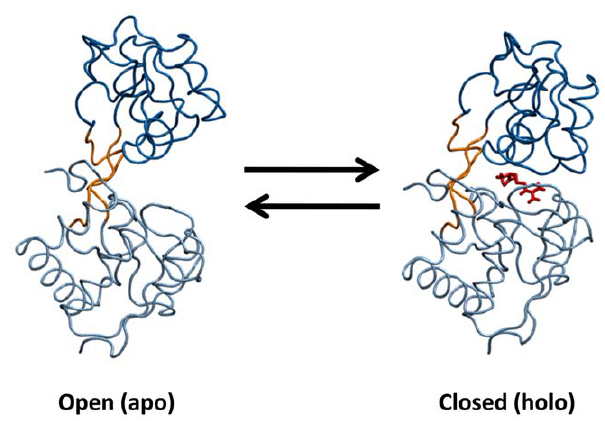
Figure 1. The open (PDB ID: 2LAO) and closed (PDB ID: 1LAF) states of the Lysine-, Arginine-, Ornithine-binding (LAO) Protein. The ligand, Arginine, is shown in red.